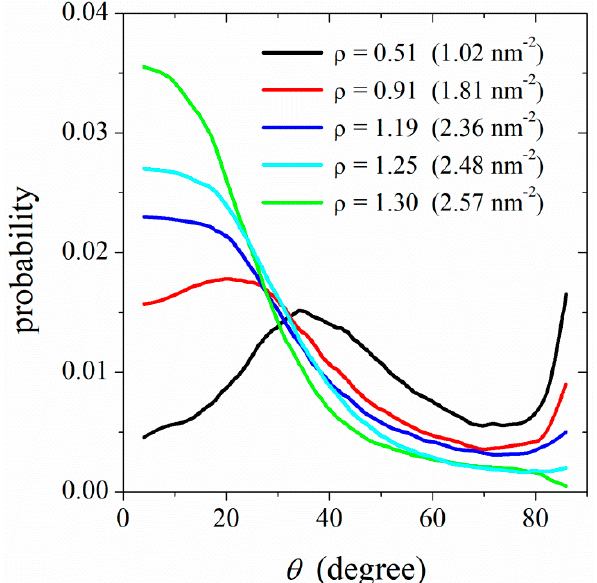
Figure 8. Surface density dependence of the orientation of lipid molecules adsorbed on the surface of CNT (20, 20). The CNT is immersed in solutions initially containing 100, 200, 300, 400, and 500 lipid molecules. The orientation angle is defined as the angle between a unit vector parallel to the tail-group beads and a unit vector normal to the CNT surface.